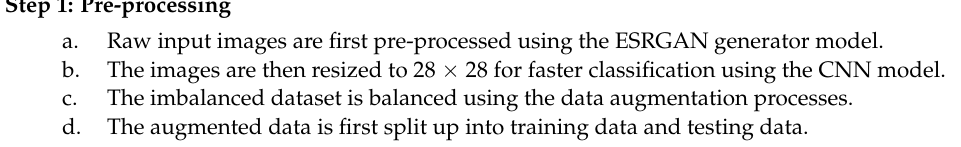
Algorithm 1: Proposed algorithm for classification of skin lesions